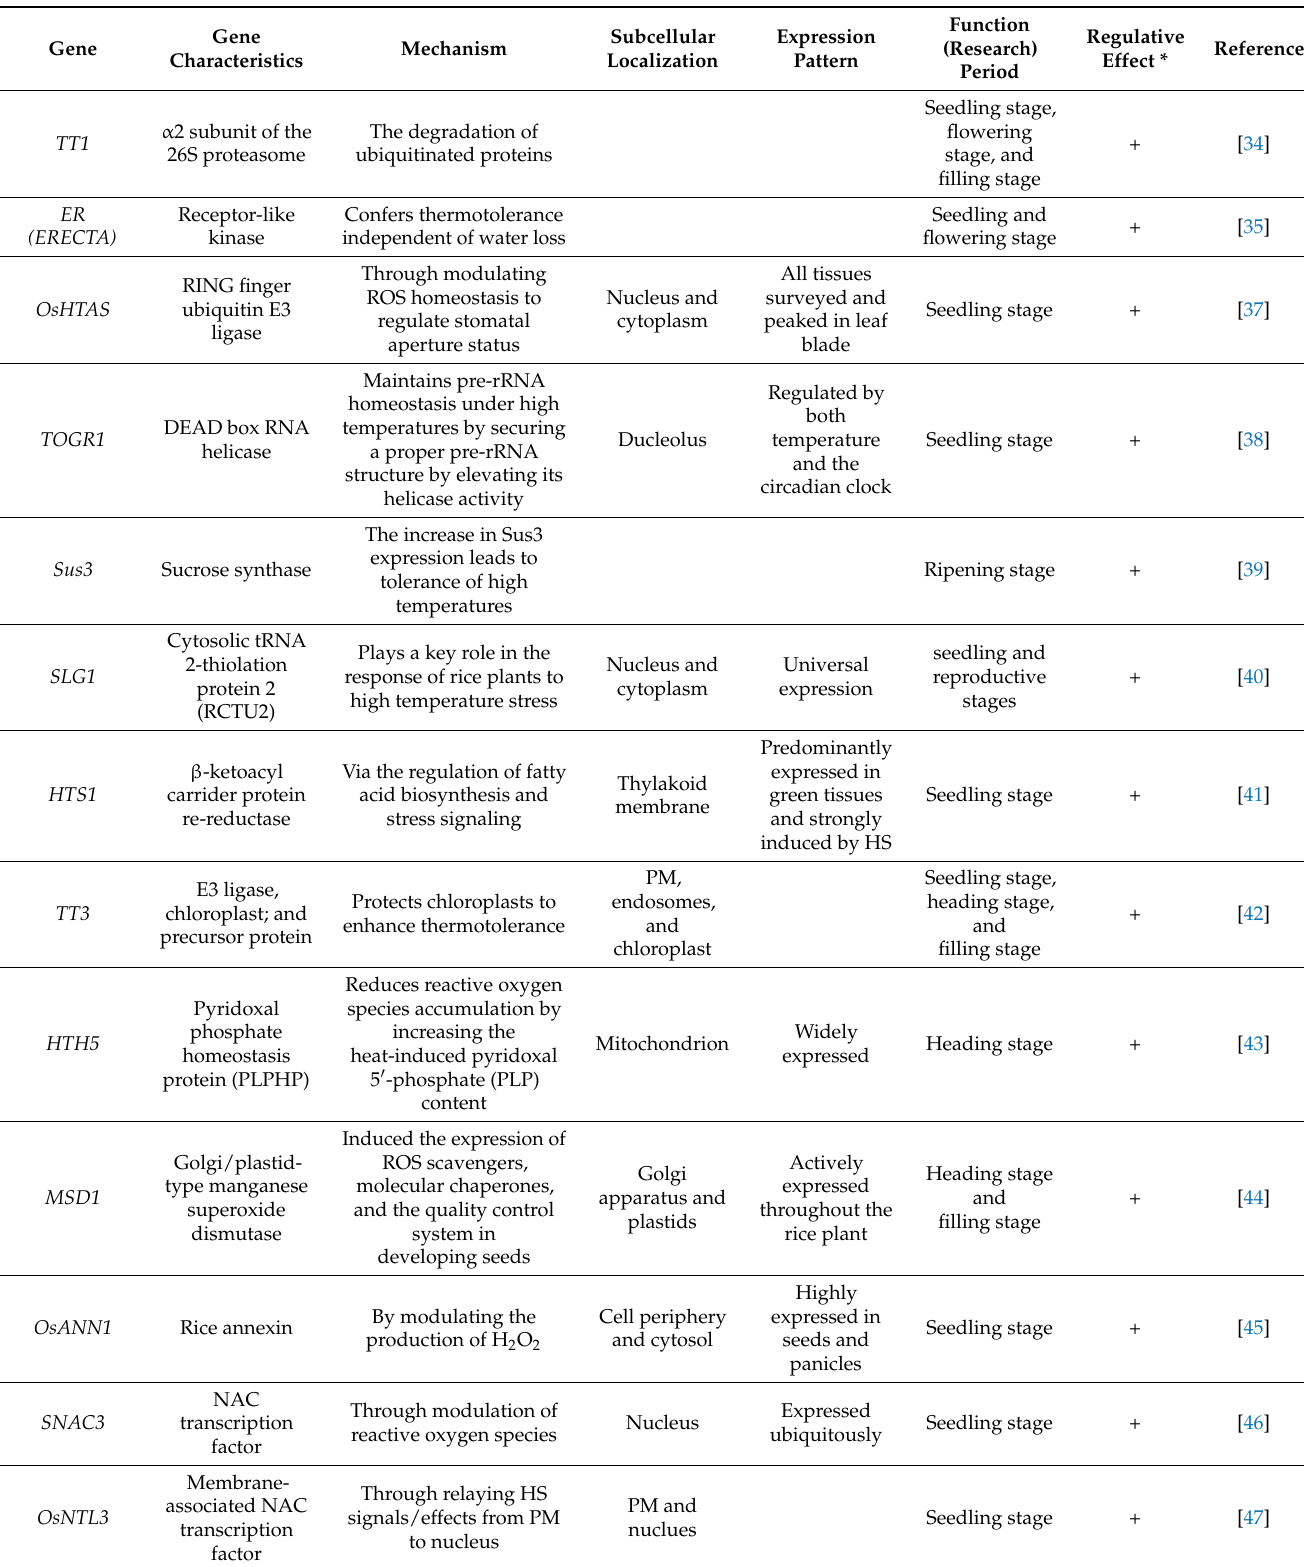
Table 1. Functional genes related to heat tolerance in rice cloned in recent